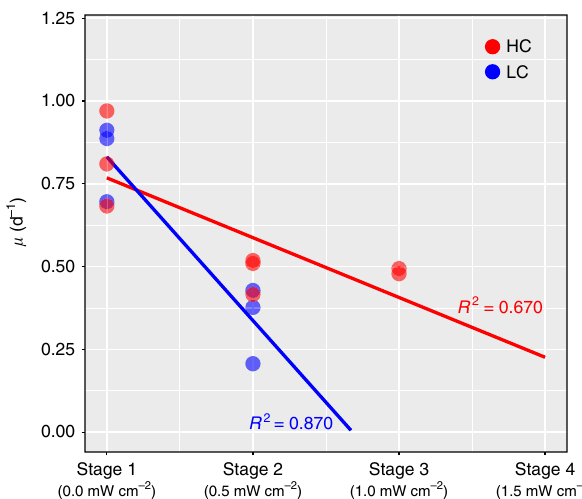
Fig. 2 Effect of CO 2 levels on growth rate dynamics of LC and HC cultures in stress test. Speci fi c growth rate of diatom cultures growing in LC conditions declines faster when subjected to incrementally higher UVR stress, relative to diatom cultures growing in HC conditions. Circles depict speci fi c growth rates for replicate cultures in HC (red) and LC (blue) conditions in stages 1 and 2 ( n = 3), and HC cultures in stage 3 ( n = 2). Lines represent linear regression of the HC and LC data